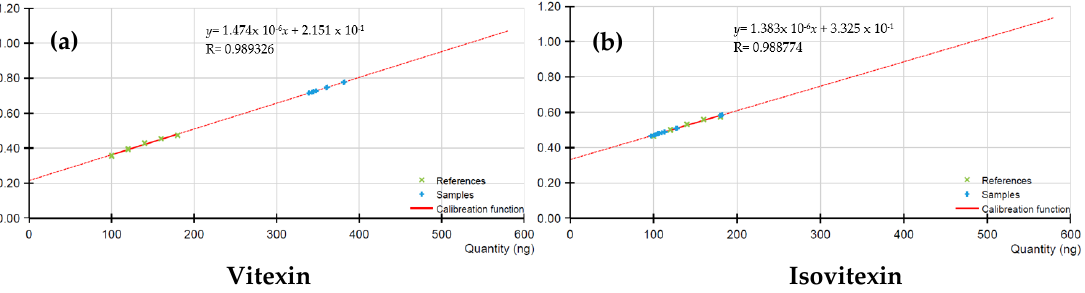
Figure 6. Standard curve for vitexin ( a ) and isovitexin ( b ) of Ficus deltoidea var deltoidea .